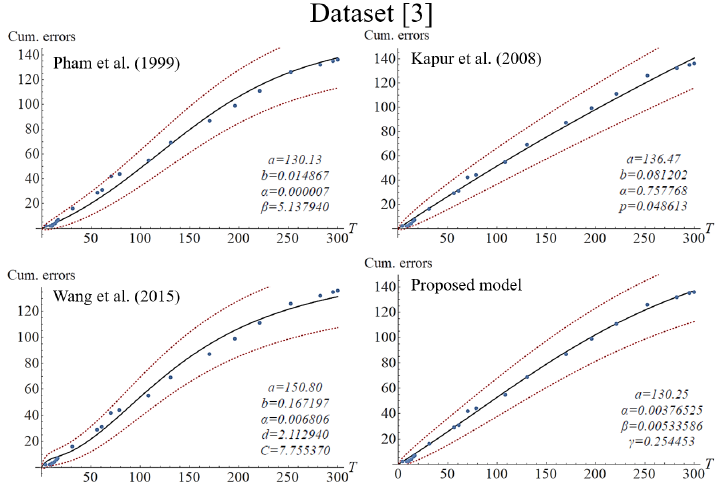
Figure 3. Goodness-of-Fit and Estimated Values of Models’ Parameters, and 95%Confidence Inter- vals for Dataset (2).